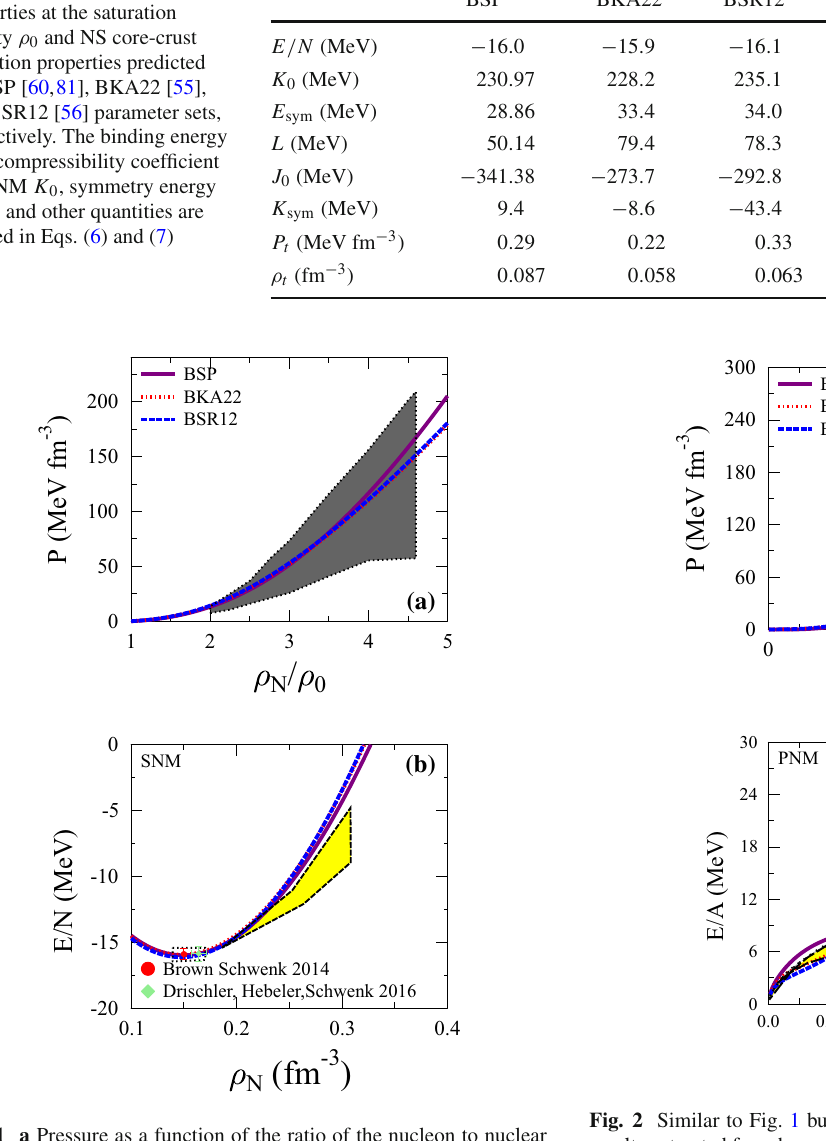
Fig. 1 a Pressure as a function of the ratio of the nucleon to nuclear saturation densities. b Energy per particle as a function of the density around the saturation density for SNM using BSP, BSR12, and BKA22 parameter sets. The Grey shaded areas on a is the results extracted from heavy-ion experimental data [96], whereas the yellow shaded area in b is the constraint imposed by the SNM binding energy near twice the saturation density extracted from the FOPI experimental data [97] and the boxed area around saturation density in b is the acceptable range of the SNM binding energy around the saturation density which is extracted from the Bethe–Weizäcker mass formula. For comparison,